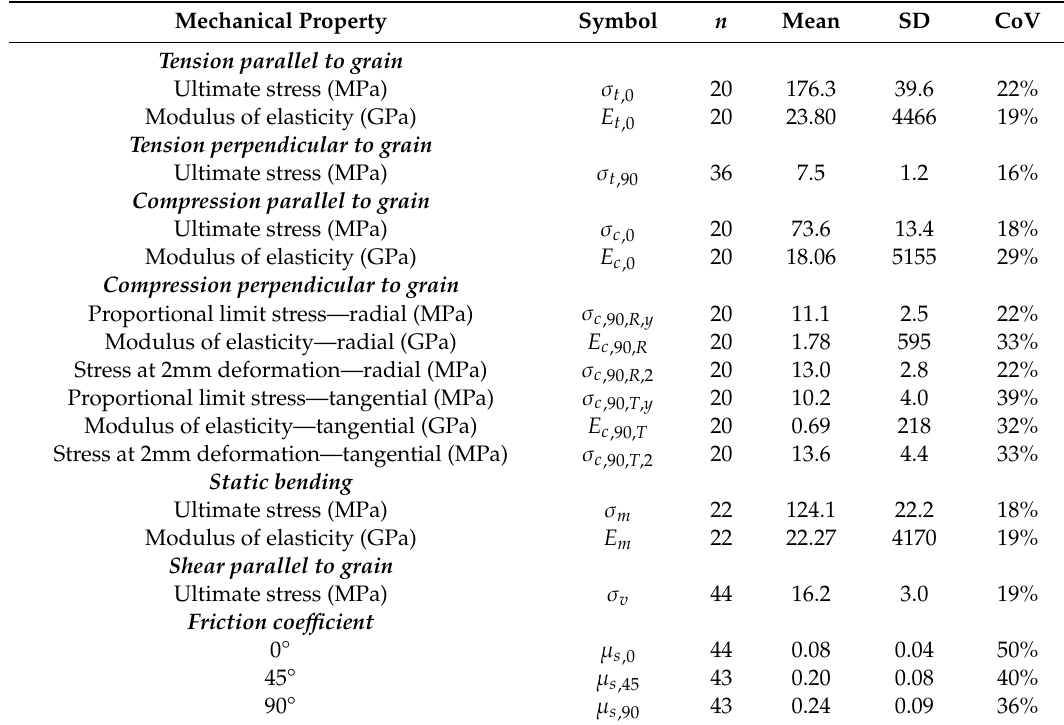
Table 1. Mechanical properties of Eucalyptus globulus L.